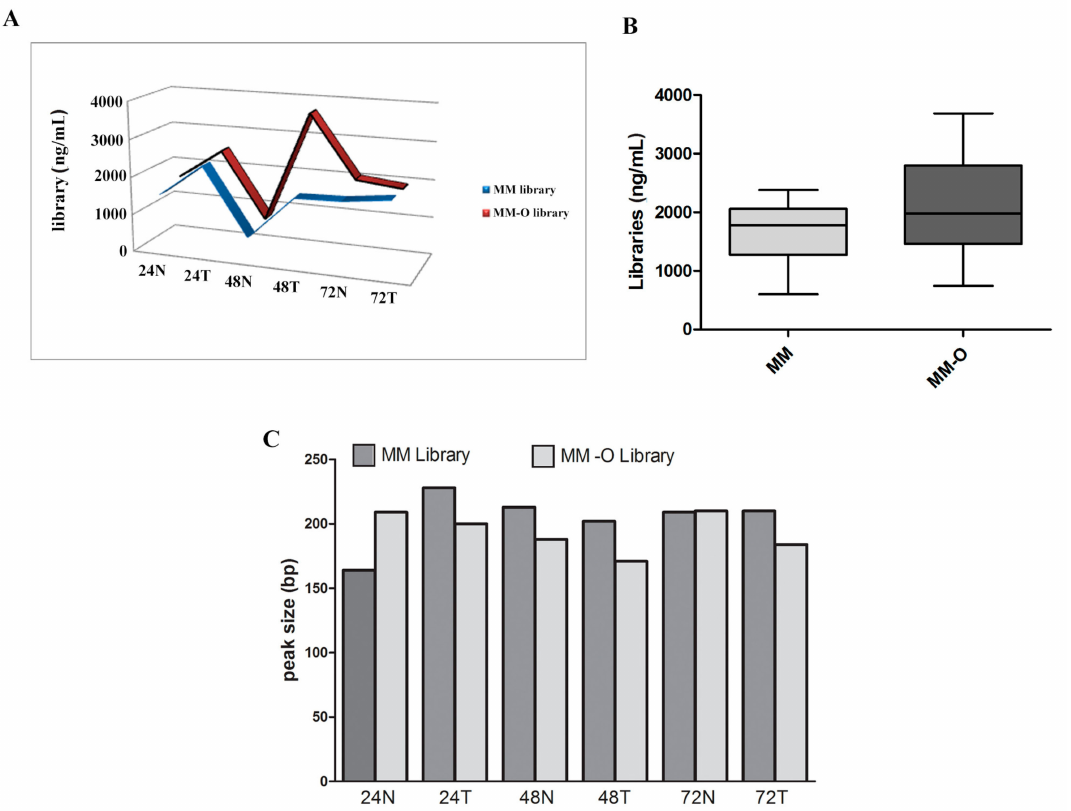
Figure 5. Library concentrations and distributions relative to the Colon and Lung Panel assay. Panels ( A )and( B )showtheconcentrationsoflibrariesobtainedfromsamplesmanually(MM)andautomatically (MM-O). Panel ( C ) represents the patterns of peak size of the same prepared samples (MM and